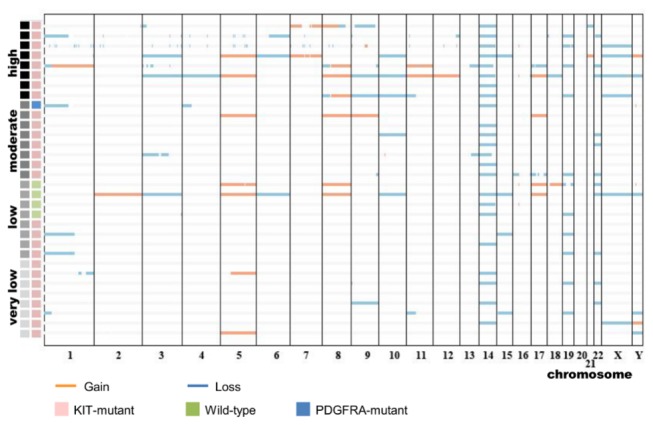
Distribution of copy number alterations in 32 gastrointestinal stromal tumors.